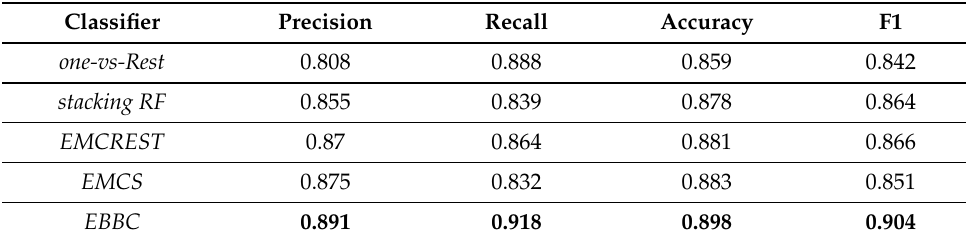
Table 7. Performance of the Multi-class classifiers. The EBBC classifier seems to perform much better than all the others.